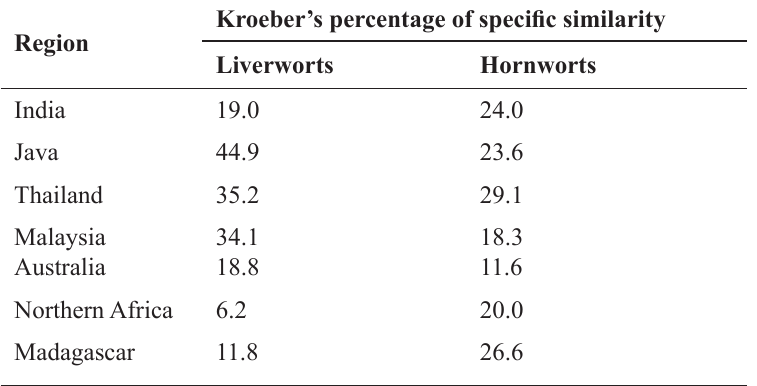
Table 3: Shared taxa of liverworts and hornworts based on Kroeber’s percentage of specific similarity.